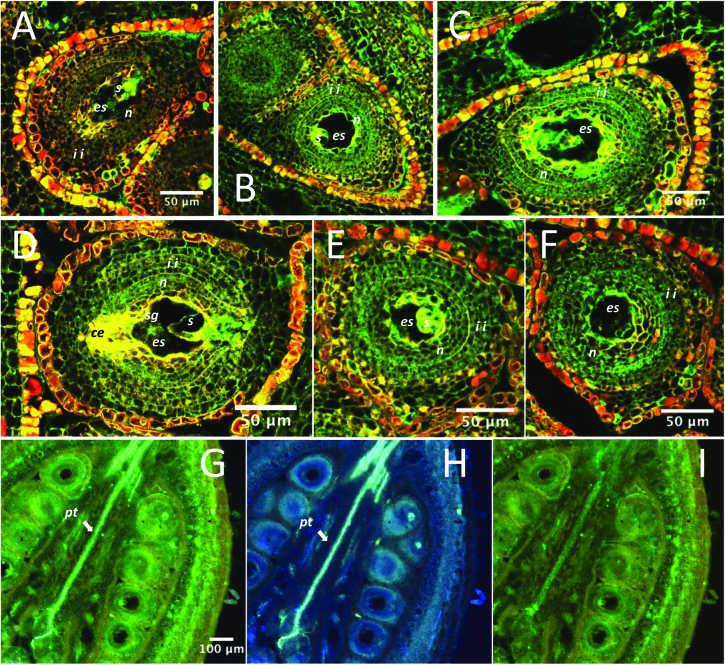
Immunolocalization of the Tc01_g007290 protein. (A–F) Confocal microscope images of sections of ovules of the Scavina 6 accession either self-pollinated (self-incompatible, SI) or pollinated by a compatible pollen (SC) and probed with a Tc01_g0007270 antibody (labelled green). (A) Controlled hybridization with pre-immuned rabbit serum for an ovule subjected to SC pollination. (B–F) Sections of ovules probed by a Tc01_g0007290 antibody: (B) SC at 8 h, (C) SI at 8 h, (D) unpollinated, (E) SC at 24 h, and (F) SI at 24 h. The Tc01_g0007290 protein appeared present in the nucellus and inner integument cells for SC and SI reactions. Its presence seemed to be reinforced in the cell layer separating the nucellus from the inner integument. (G–I) The presence of the Tc01_g0007290 protein was visualized as described in Fig. 4. The protein was not apparent in the pollen tubes. Abbreviations: es, embryo sac; s, synergid cell; sg, starch grains surrounding the polar nucleus; n, nucellus; ii, inner integuments; ce, chalazal end; pt, pollen tube.